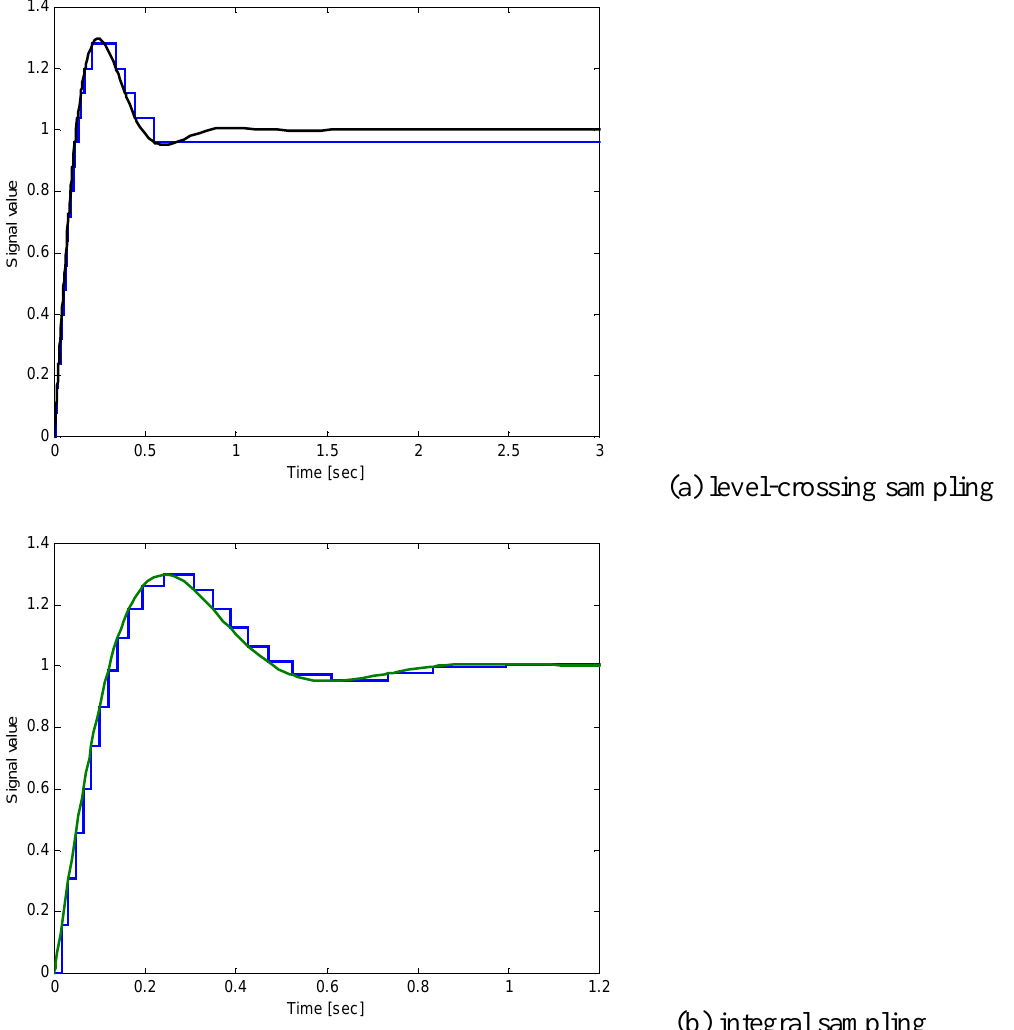
Figure 2. The steady-state sampling error in the level-crossing scheme (a), the example of the event- based sampling according to the integral criterion (b). The sampled signal is the same in both plots (a) and (b), only the time scales are